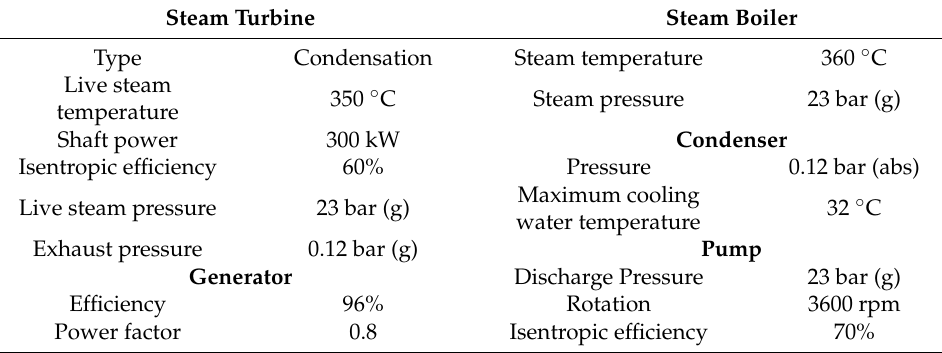
Table 6. Rankine cycle parameters [32–34].